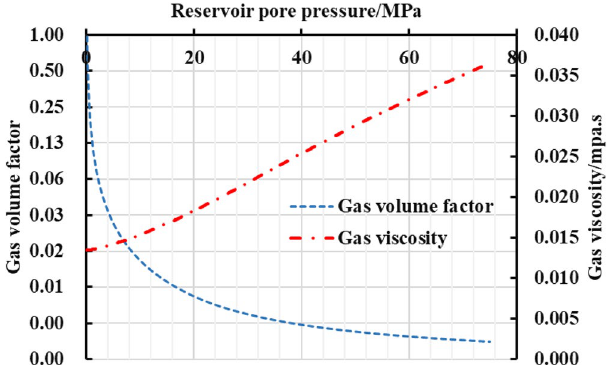
Figure 11. The relationship between gas volume coefficient and viscosity and